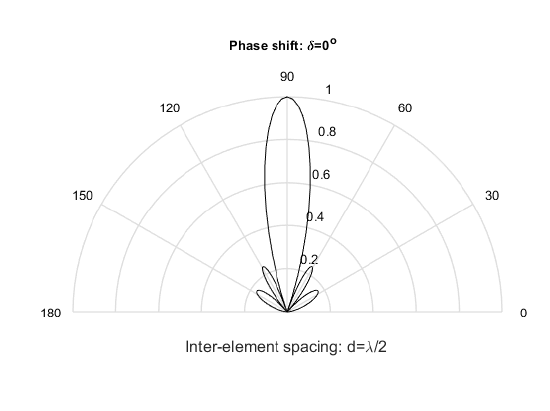
Figure 1. Polar beam pattern of an array antenna that has 6 elements, inter-element spacing = λ δ = 0 ◦